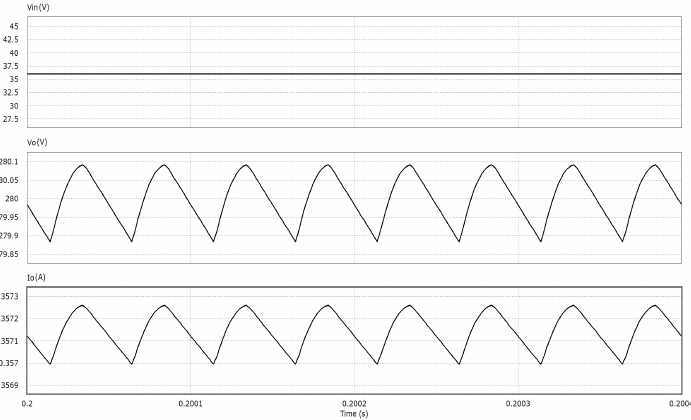
Figure 11. PSIM simulation of input voltage, output voltage and output